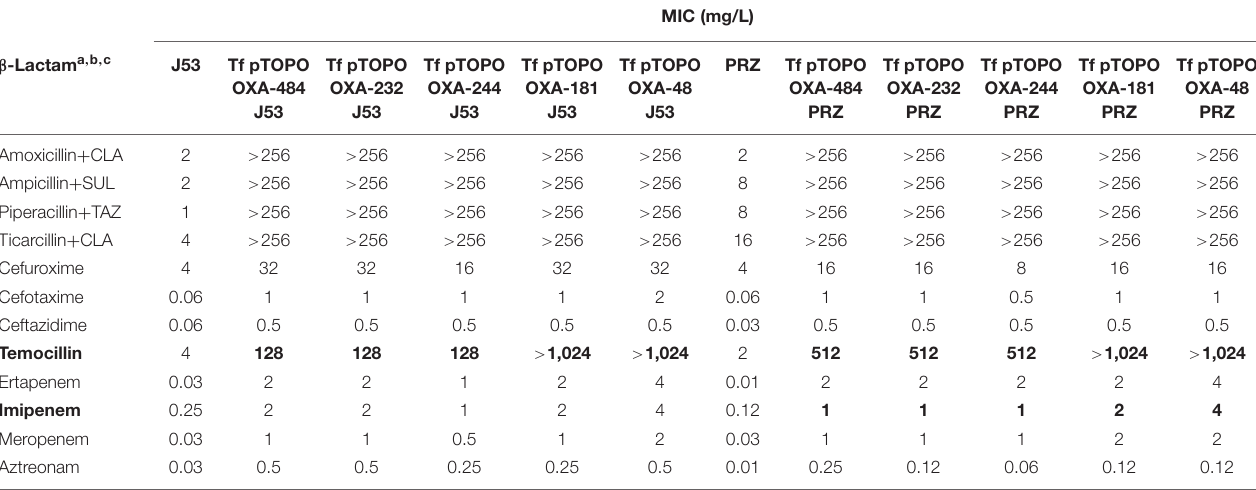
FIGURE 3 | Transconjugation frequencies during horizontal transfer of plasmids harboring bla OXA - 484 , bla OXA - 181 , and bla OXA - 48 from E. coli and K. pneumoniae clinical isolates to E. coli J53 and K. quasipneumoniae subsp. quasipneumoniae PRZ. Each dot represents the frequency of a single transconjugation experiment, whereas the bars indicate the mean of all experiments. *** P < 0.0001 (Mann-Whitney U test). Transconjugation frequencies to (A) E. coli J53 and (B) K. quasipneumoniae subsp. quasipneumoniae PRZ. TABLE 3 | MICs of E. coli J53 and K. quasipneumoniae subsp. quasipneumoniae PRZ transformants (Tf) harboring pTOPO plasmids encoding bla OXA − 484 , bla OXA − 232 , bla OXA − 244 , bla OXA − 181 , and bla OXA − 48